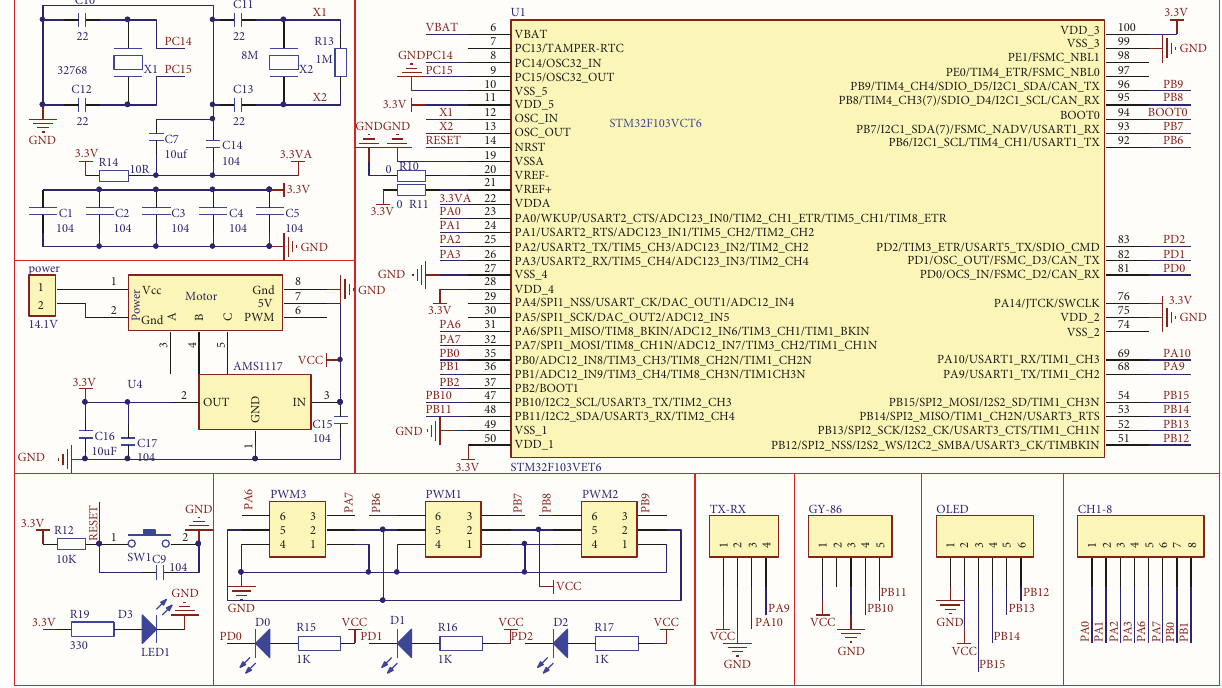
Figure 5: Flight control system